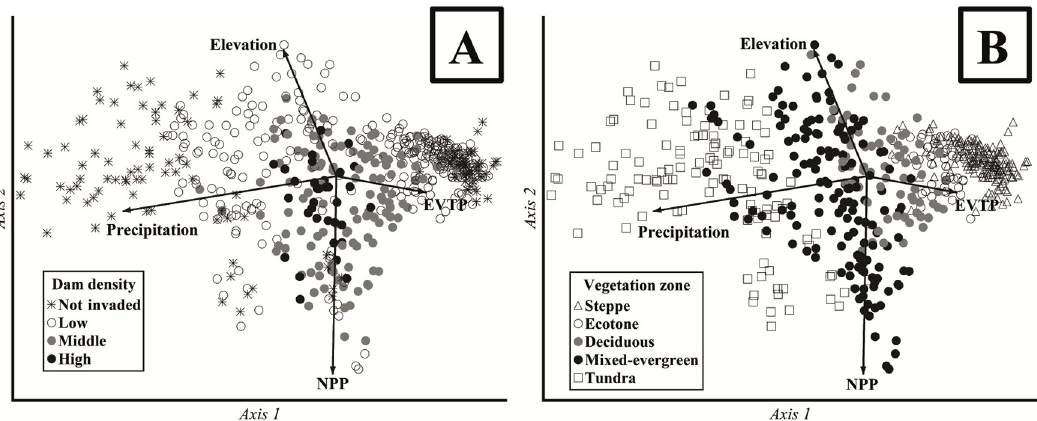
Fig 7. Principal components analysis (PCA) using the analyzed geographic, climatic and topographic factors. The plots were classified according to (A) beaver dam density (dams per km 2 ) considering the not invaded (zero dams), low density (1 to 5 dams), middle density (5 to 15 dams) and high density ( > 15 dams) areas; and (B) the vegetation zones (steppe, ecotone, deciduous, mixed- evergreen, tundra). Distance to streams, temperature and slope were not graphically represented. NPP = net primary productivity, EVTP =